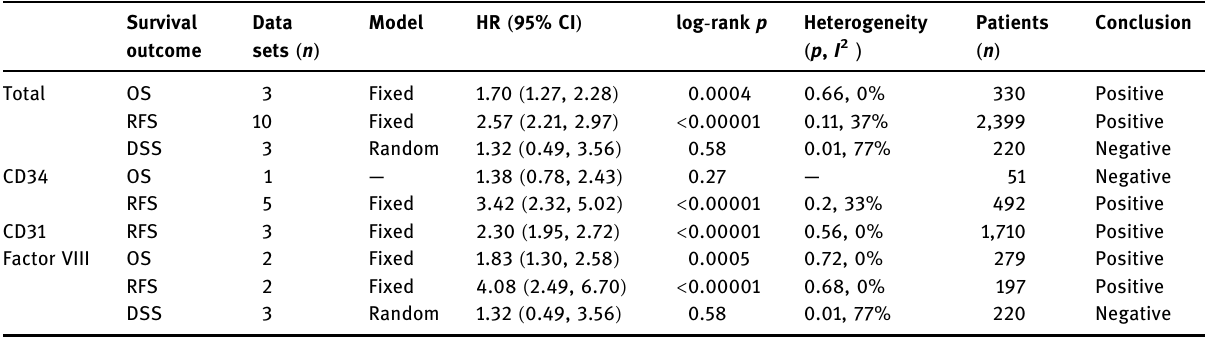
Table 2: Meta - analysis of MVD expression in prostate cancer: hazard ratios and con fi dence intervals to predict the survival